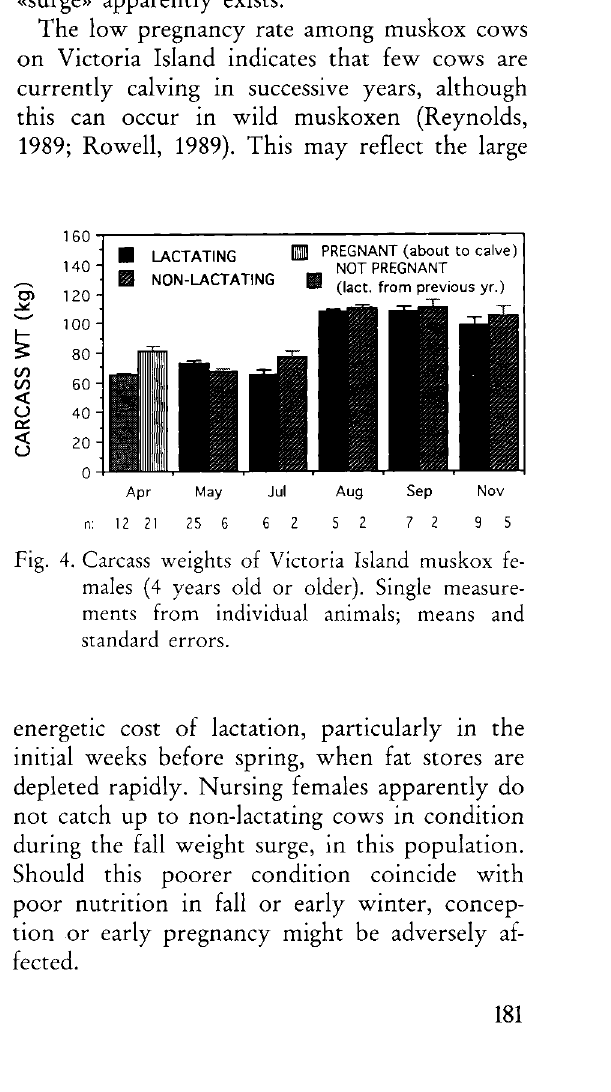
Fig. 3 a. Body weights of Victoria Island muskox fe males (4 years old or older). Single measure ments from individual animals; means and standard errors.